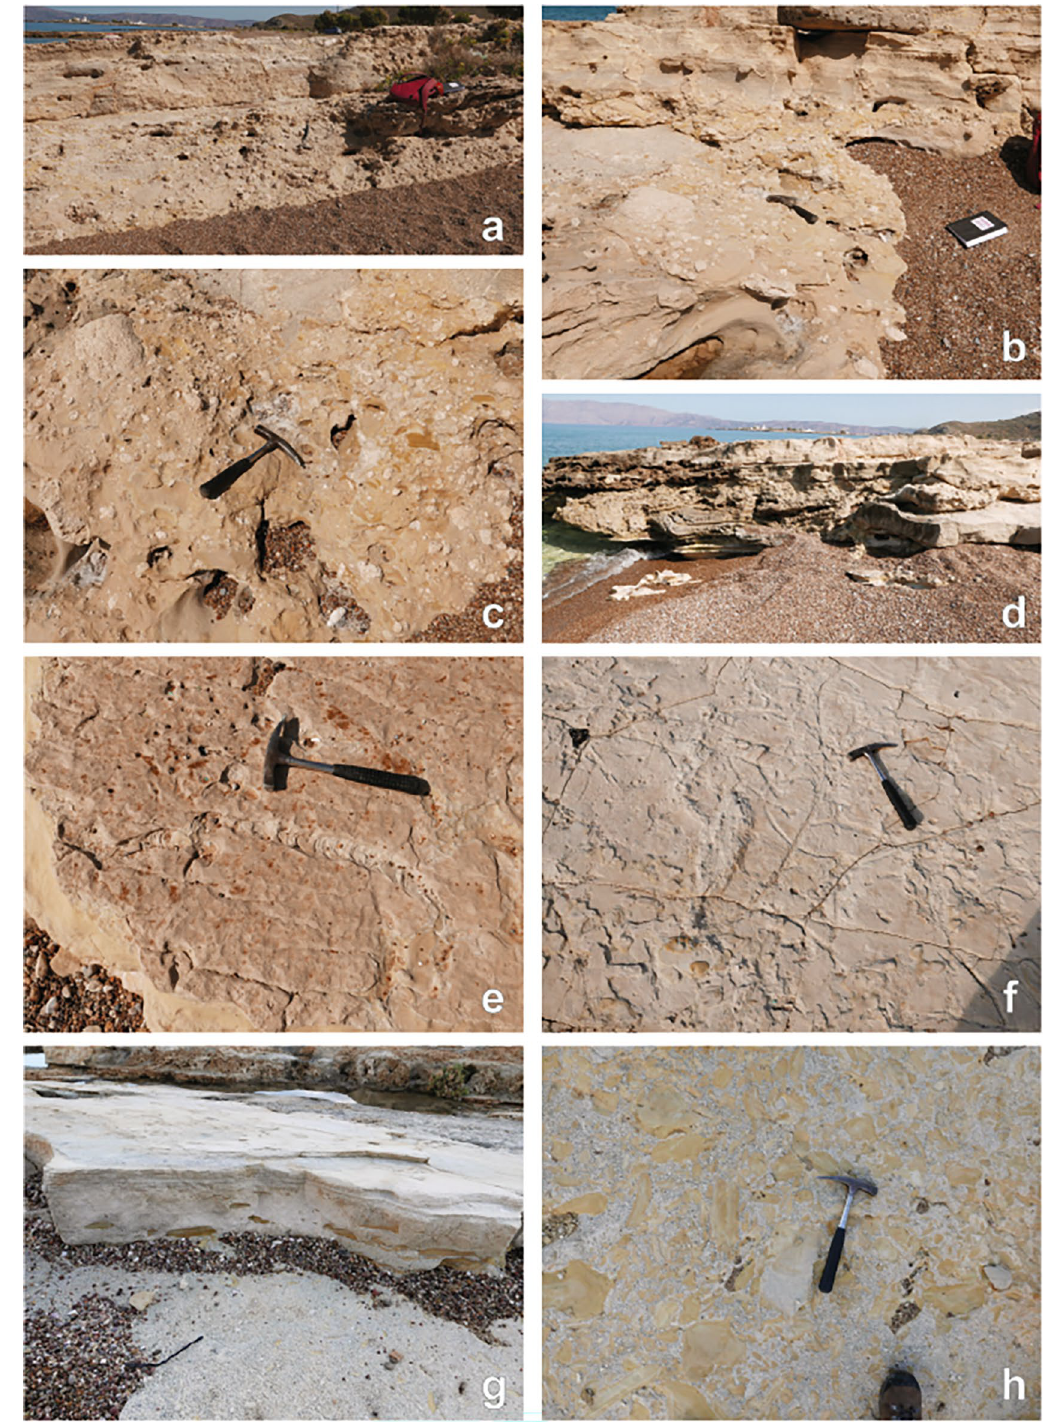
Figure 5. Pictures of the Trachilos sediments: ( a–c ) debris flow deposit of silty marls, calcarenites and algal nodules; ( d ) debris flow deposit between slumped (below) and in situ turbiditic calcarenites (above); ( e–f ) burrows on top of fine calcarenites; ( g ) silty marl pebbles/flakes (with sample C) in the coarse calcarenite just below the footprint